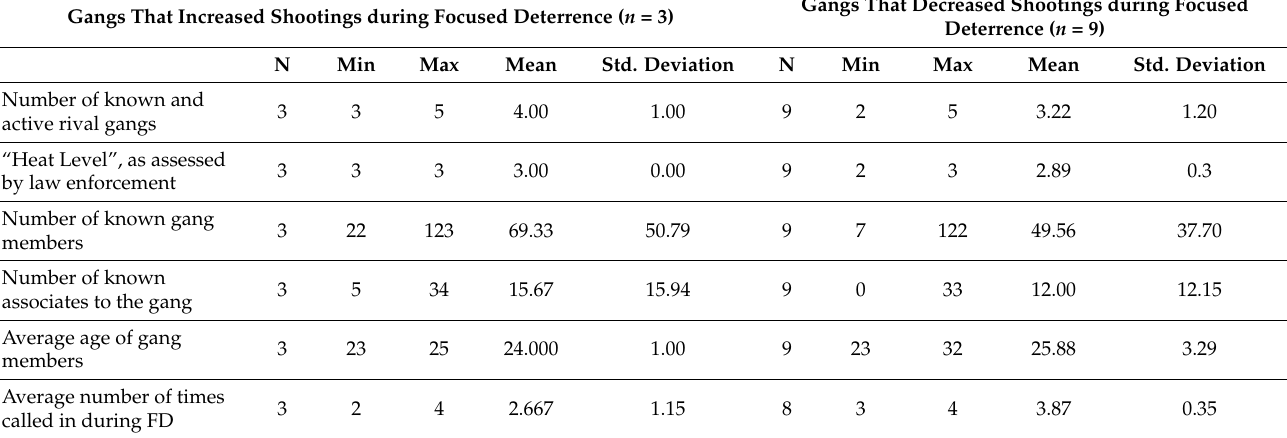
Table 2. Gang-level social media descriptive statistics by change in